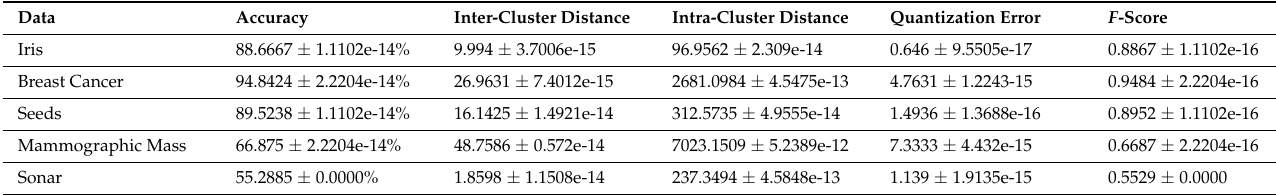
Table 4. Results from the Fuzzy C-Means